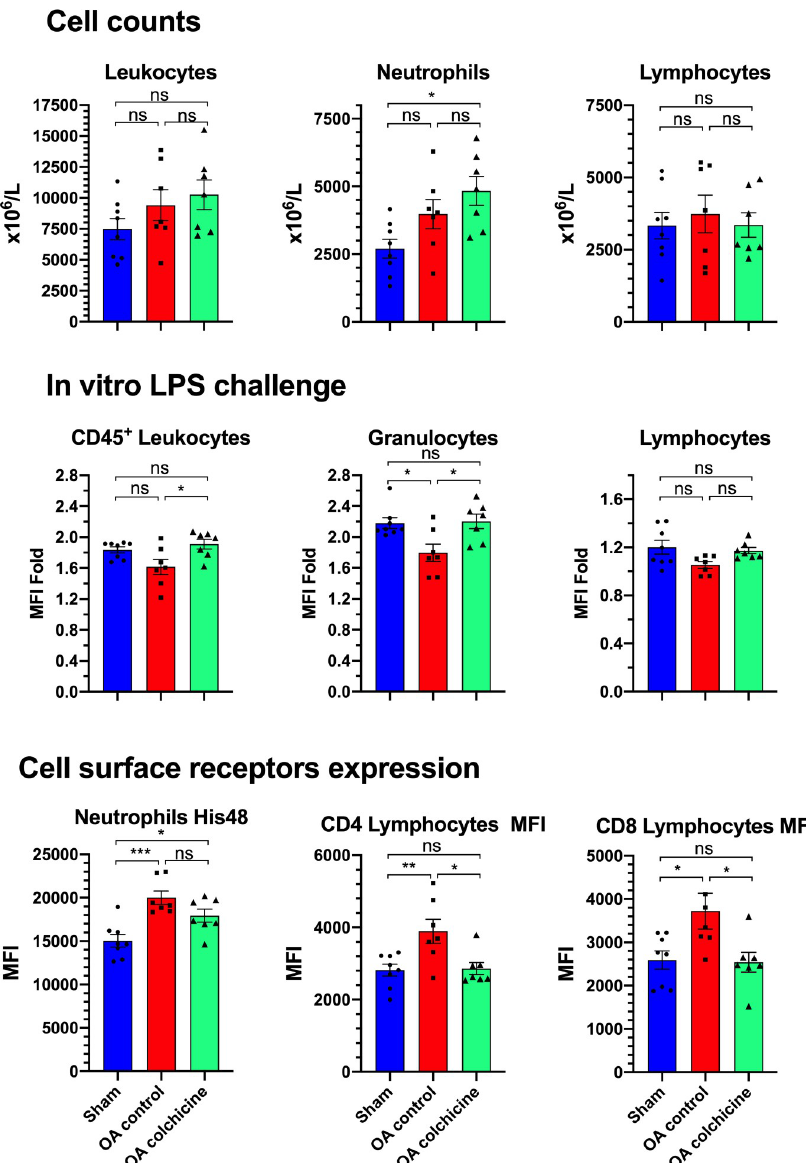
Fig 4. Whole blood flow cytometry analysis of leukocytes after oleic acid-induced ALI and effects of colchicine therapy. MFI, mean fluorescence intensity. Values are mean ± SEM. ��� p < 0.001, �� p < 0.01; � p < 0.05.